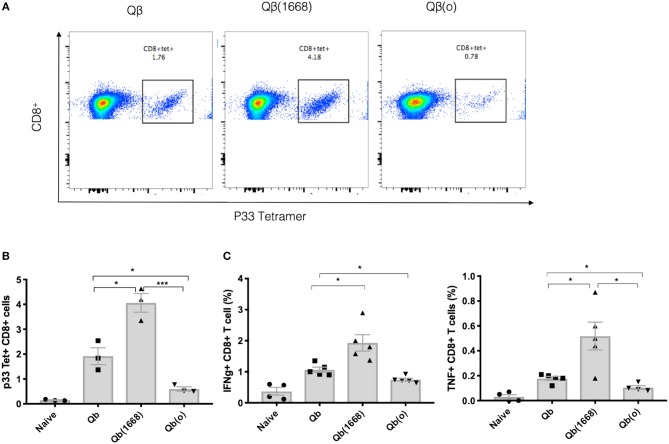
Packaging of CpGs on VLP alters the immune response induced by VLPs. C57BL/6 mice were vaccinated s.c. with 50 μg of VLP-p33 containing RNA (E. coli), CpG class B or the empty capsid. (A,B) p33-specific tetramer staining of CD8+ T cells from 3 immunized mice and (C) ICS staining of CD3+CD8+ T cells 7 days post vaccination. 6 h stimulation with p33 peptide from 5 immunized mice. Data represented as Mean ± SEM. Statistical significance was measured by unpaired two tailed t-tests followed by Bonferroni-Dunn's correction for multiple testing. *p < 0.01, ***p < 0.0009. Data is representative of 3 independent experiments.